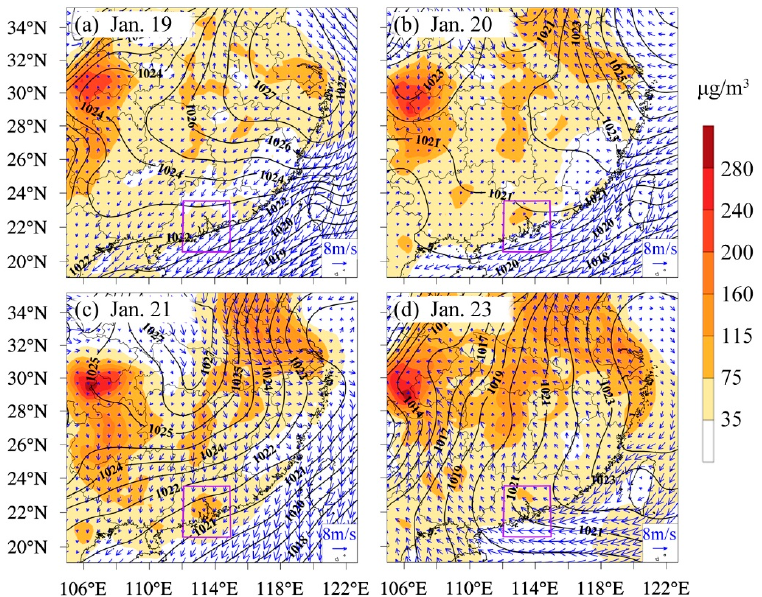
Figure 8. The simulation results of the daily average near-surface PM 2.5 concentration (shaded; unit: µ g / m 3 ), 10-m wind field (blue vector; unit: m / s) and sea level pressure (black contour; unit: hPa). From ( a ) to ( d ) are 19, 20, 21, and 23 January, respectively (the solid purple box refers to the emissions control region).